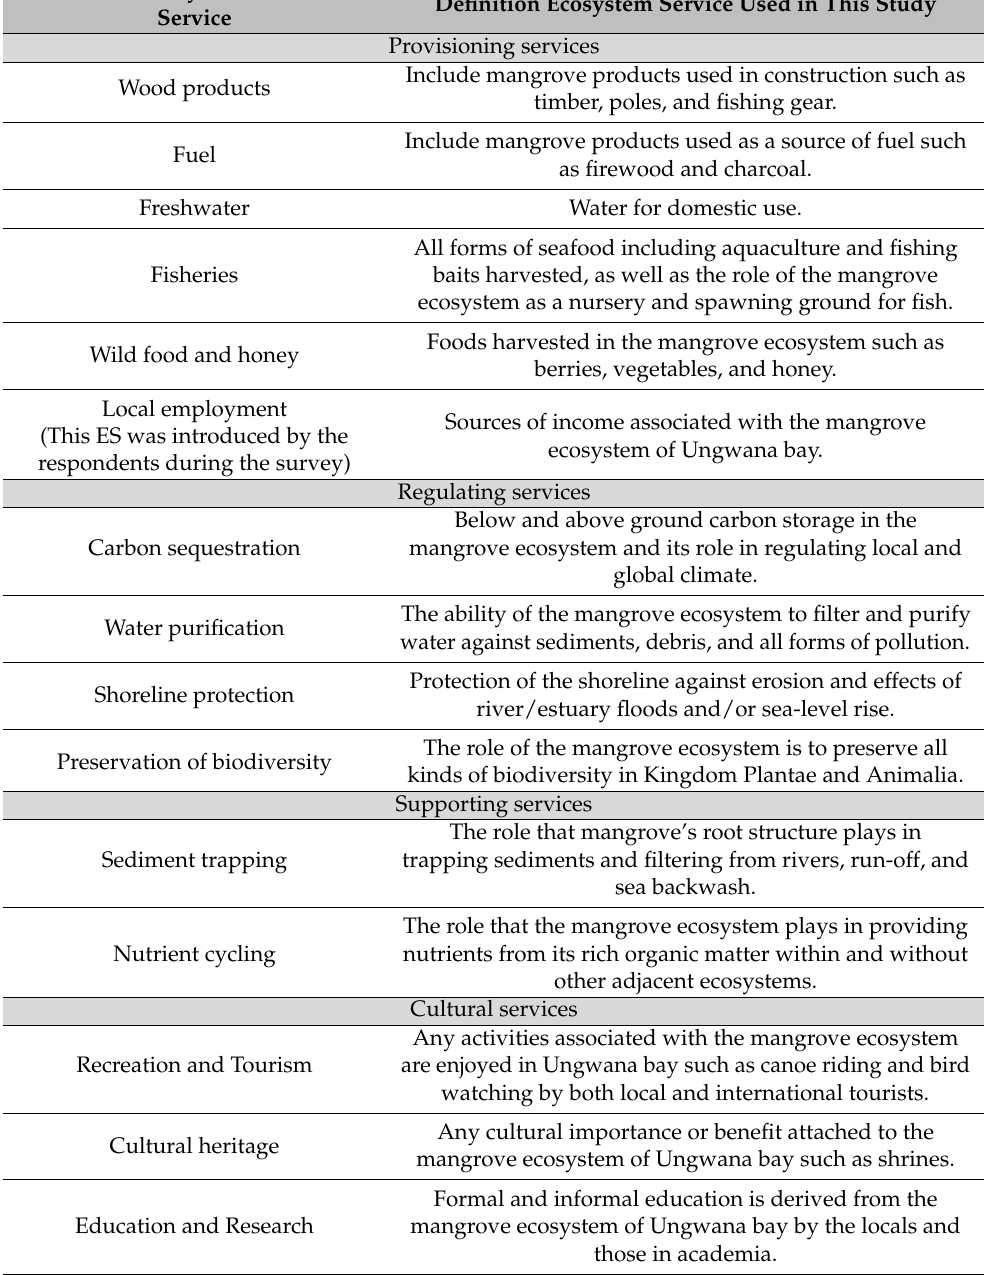
Table 1. A description of the surveyed ES in Ungwana bay, Kenya was adapted with permission from Owuor et al.